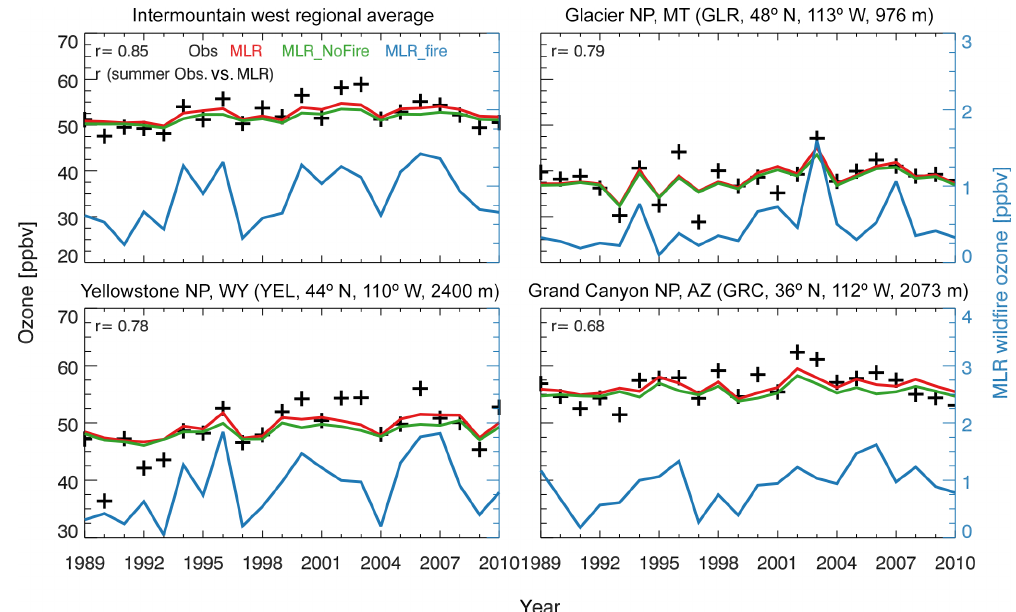
Figure 7. Time series of summer mean MDA8 ozone concentrations for the regional averages of eight CASTNet sites with complete 22-year measurements as well as three individual sites. Measurements (black pluses) are compared to the MLR model results (red line). Also shown are the summer mean MLR no wildfire ozone (green line) and MLR wildfire ozone (blue line, right axis). The correlations between measured and MLR summer means are shown